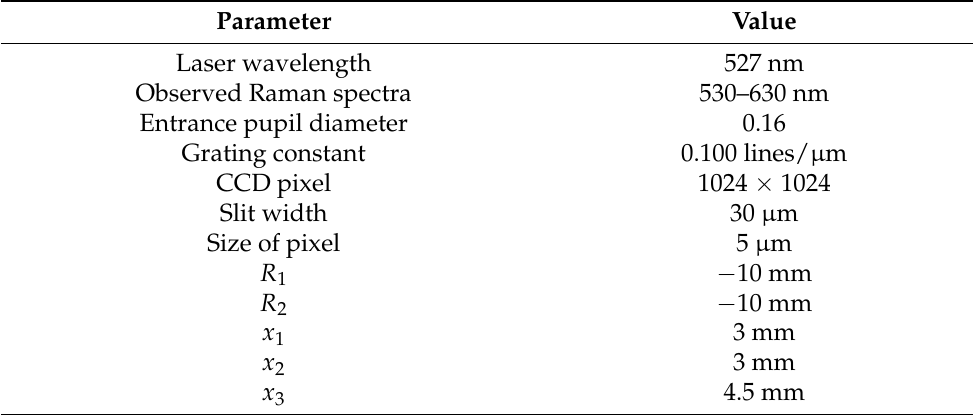
Figure 1. ( A ) Layout of Raman spectrometer: A laser beam is scattered from samples; this passes through the slit, is collimated by a mirror and is directed to diffraction grating, which resolves the wavelengths, which, in turn, are finally directed to the charge coupled device (CCD) by a focusing mirror. ( B ) Analysis of the imaging plane in Raman spectrometer. The initial parameters of the system design are shown in Table 2. Table 2. Initial structure parameters of Raman spectrometer